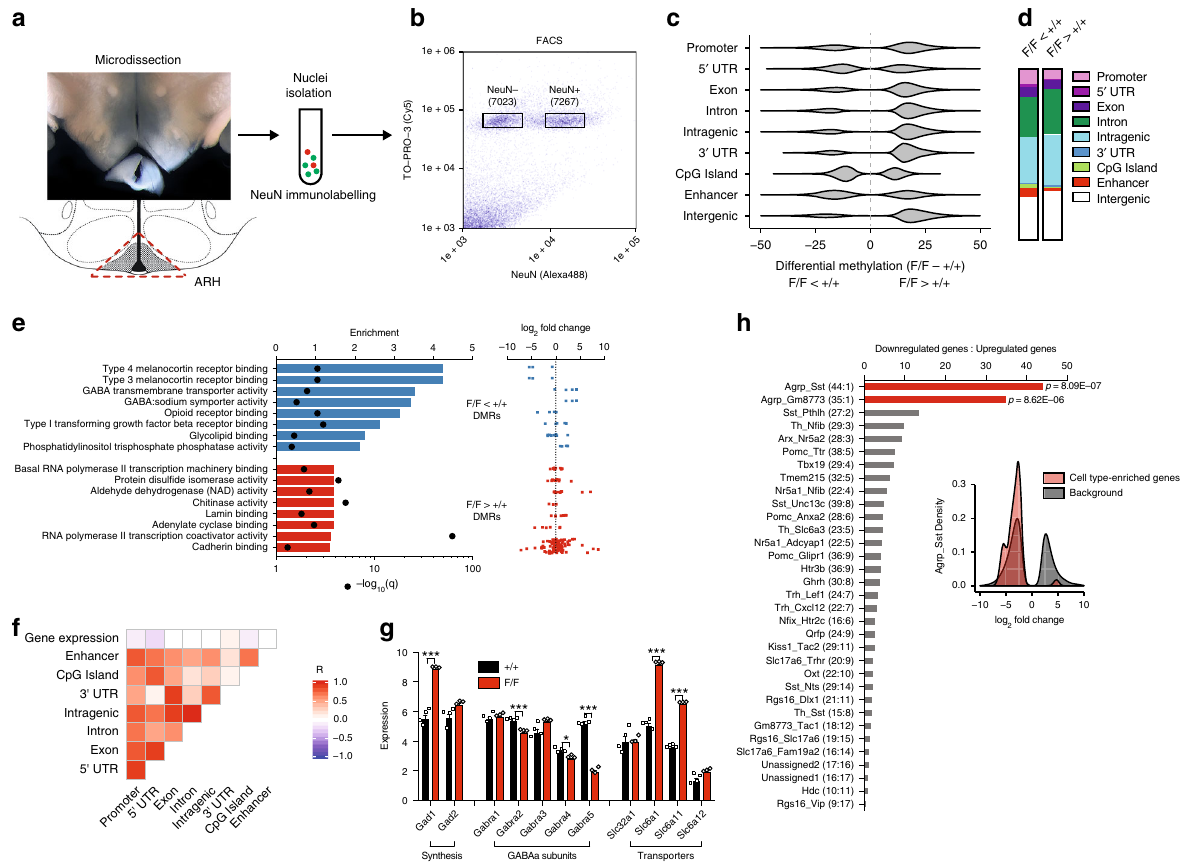
Fig. 3 Widespread changes in DNA methylation and gene expression point to disruptions in melanocortin and GABAergic neural signaling. a Illustration of experimental strategy to limit cellular heterogeneity by microdissection of ARH at P12 followed by NeuN immunolabelling to isolate neuronal nuclei by FACS. b Representative FACS plot showing gating strategy used to isolate neural (NeuN + ) nuclei (see also Supplementary Fig. 3A). c Violin plot showing genomic localization and methylation levels of hypomethylated and hypermethylated DMRs in ARH neurons as determined by whole-genome bisul fi te sequencing. Hypermethylated DMRs predominate in F/F mice except in CpG island, 5 ′ -UTR and enhancer regions. d Proportional genomic distribution of hypo- and hypermethylated DMRs. e Gene ontology (GO) function analysis of GREAT-de fi ned 22 cis -regulatory region-associated DMRs shows signi fi cant enrichment of genes associated with melanocortin signaling, GABAergic neurotransmission, and TGF- β signaling among hypomethylated DMRs (left). Genes belonging to the melanocortin signaling GO term tend to be downregulated in F/F mice, while genes associated with GABAergic neurotransmission tend to be upregulated in F/F mice (right). f Correlogram showing Pearson correlation coef fi cients ( R ) between DMR methylation level in each genomic region relative to other regions in the same gene, and expression of the associated gene. g Signi fi cant changes in the expression of GABA synthesis genes ( Gad1 ), receptor subunits ( Gabra2, 4, 5 ), and transporters ( Slc6a1, Slc6a11 ). h Differential expression of genes speci fi c to de fi ned ARH neural cell types 25 . Cell types are ranked according to ratio of down- to upregulated genes characteristic of that cell type. Numbers of signi fi cantly down- and upregulated genes associated with each cell type are provided. Inset: representative density plot showing log 2 fold change values for differentially expressed genes enriched in Agrp_Sst neurons relative to a background list of all genes with signi fi cant differential expression. p -Values represent results of χ 2 test against background list of signi fi cantly up- and downregulated genes. Values re fl ect mean± SEM; n = 3 – 5, * p < 0.05, *** p <0.001. Source data for g provided as a Source Data fi